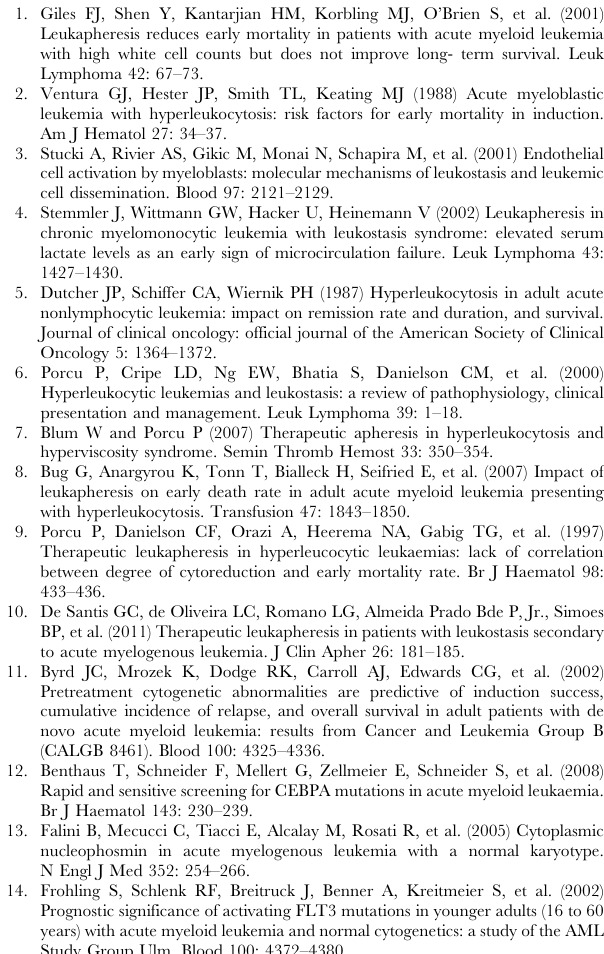
Table S3 Unviarate logistic regression for early death within 7 days (ED d7 ). Overview of significant parameters